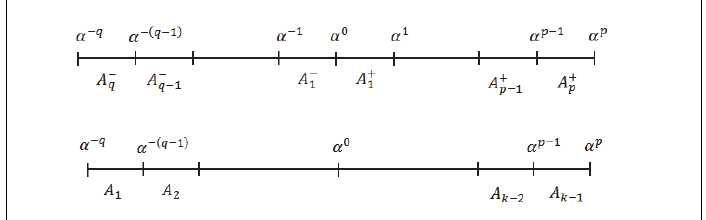
Fig. 1. Notations used for reference levels and the resulting